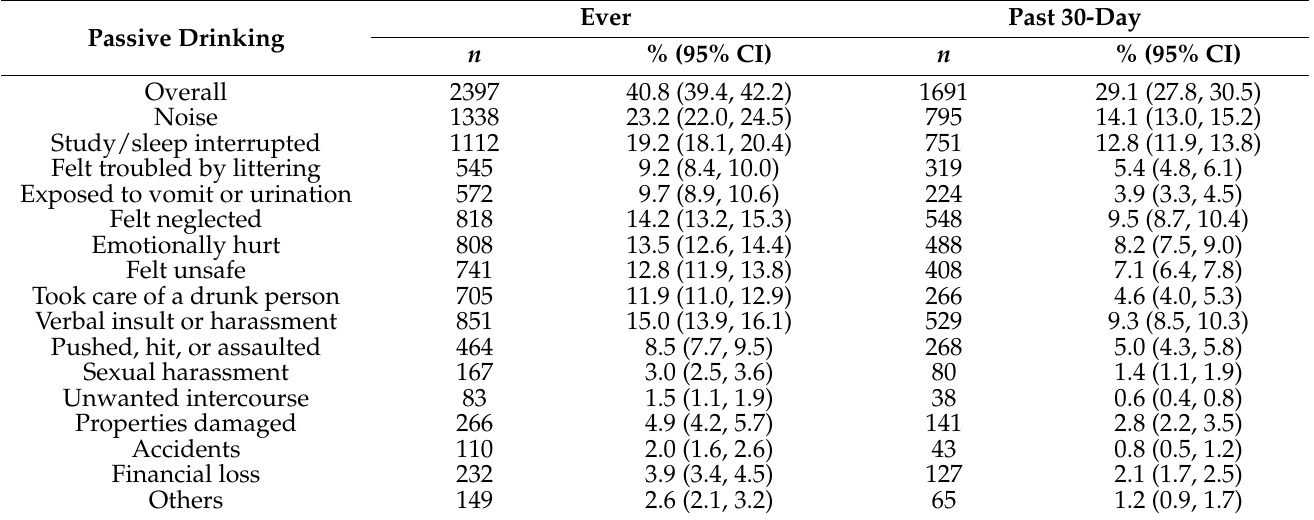
Table 2. Prevalence of passive drinking of 5840 participants a .